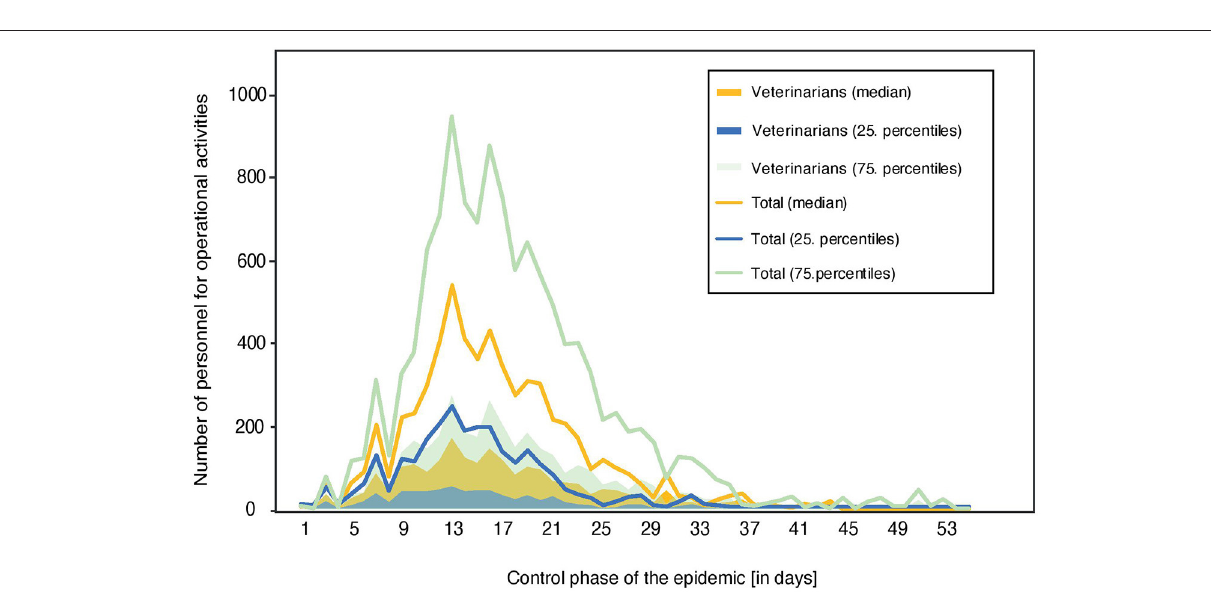
FIGURE 2 | The number of human resources, stratified by veterinarians and total personnel which are required to perform the operational activities in the reference scenario (SO) during the control phase of an FMD epidemic in Austria. N.B. Staffs employed in national and local coordination centers are not